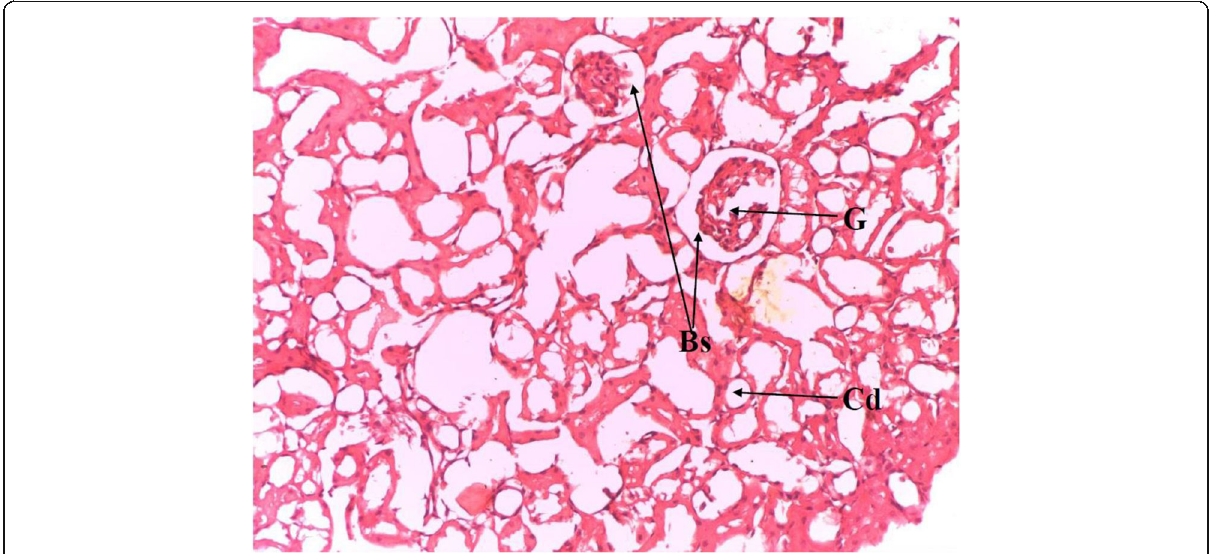
Fig. 11 Photomicrograph of kidney section of rat administered ethanolic fruits ’ extract of X. aethiopica (100 mg/kg bw) showing normal glomerulus (G), Bowman ’ s spaces (Bs), collecting ducts (Cd) and Bowman ’ s capsule